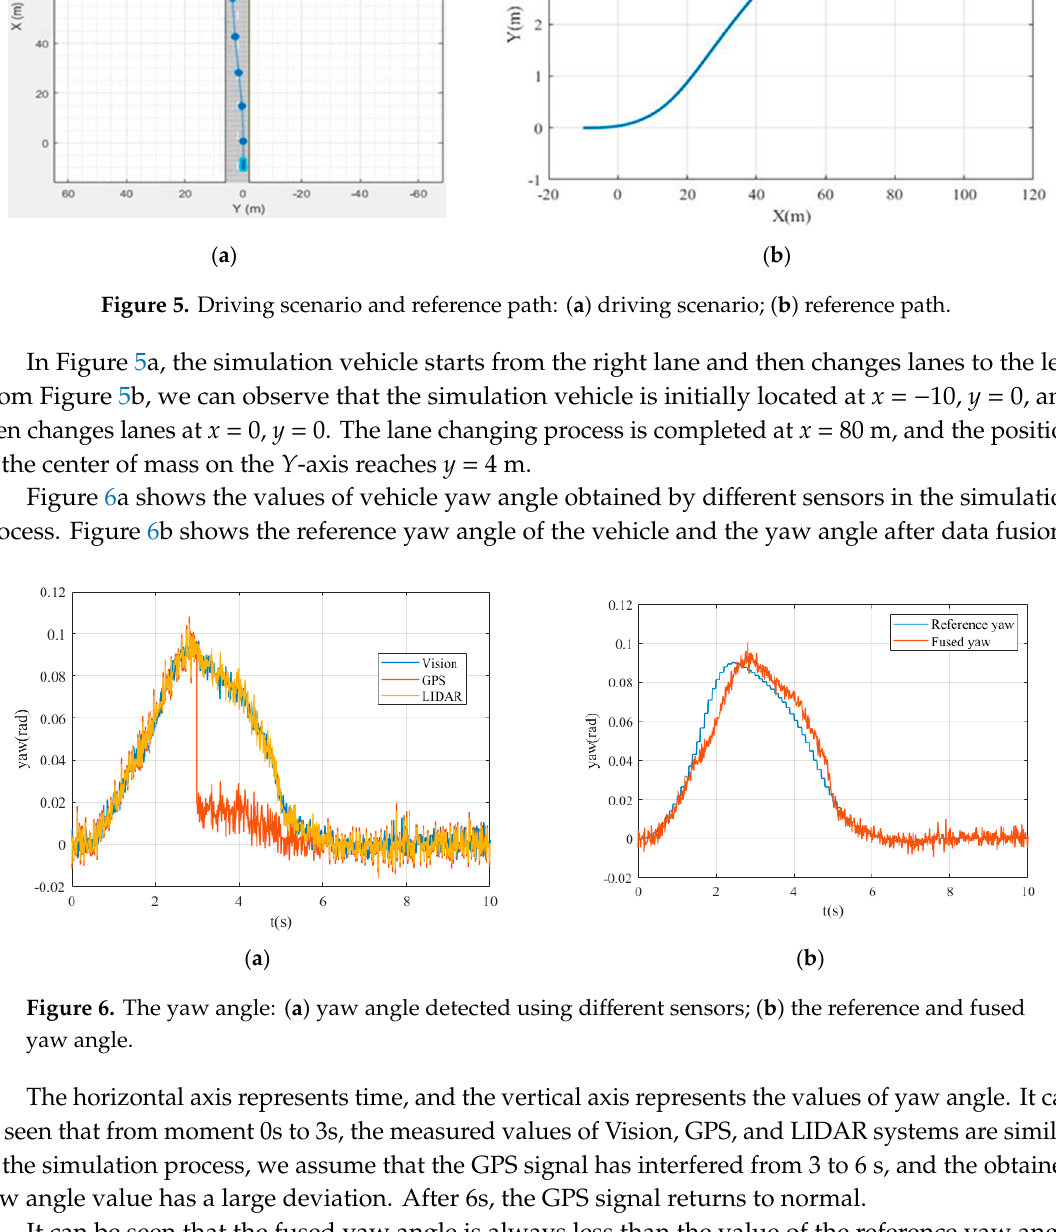
Figure 6. The yaw angle: ( a ) yaw angle detected using different sensors; ( b ) the reference and fused yaw angle.